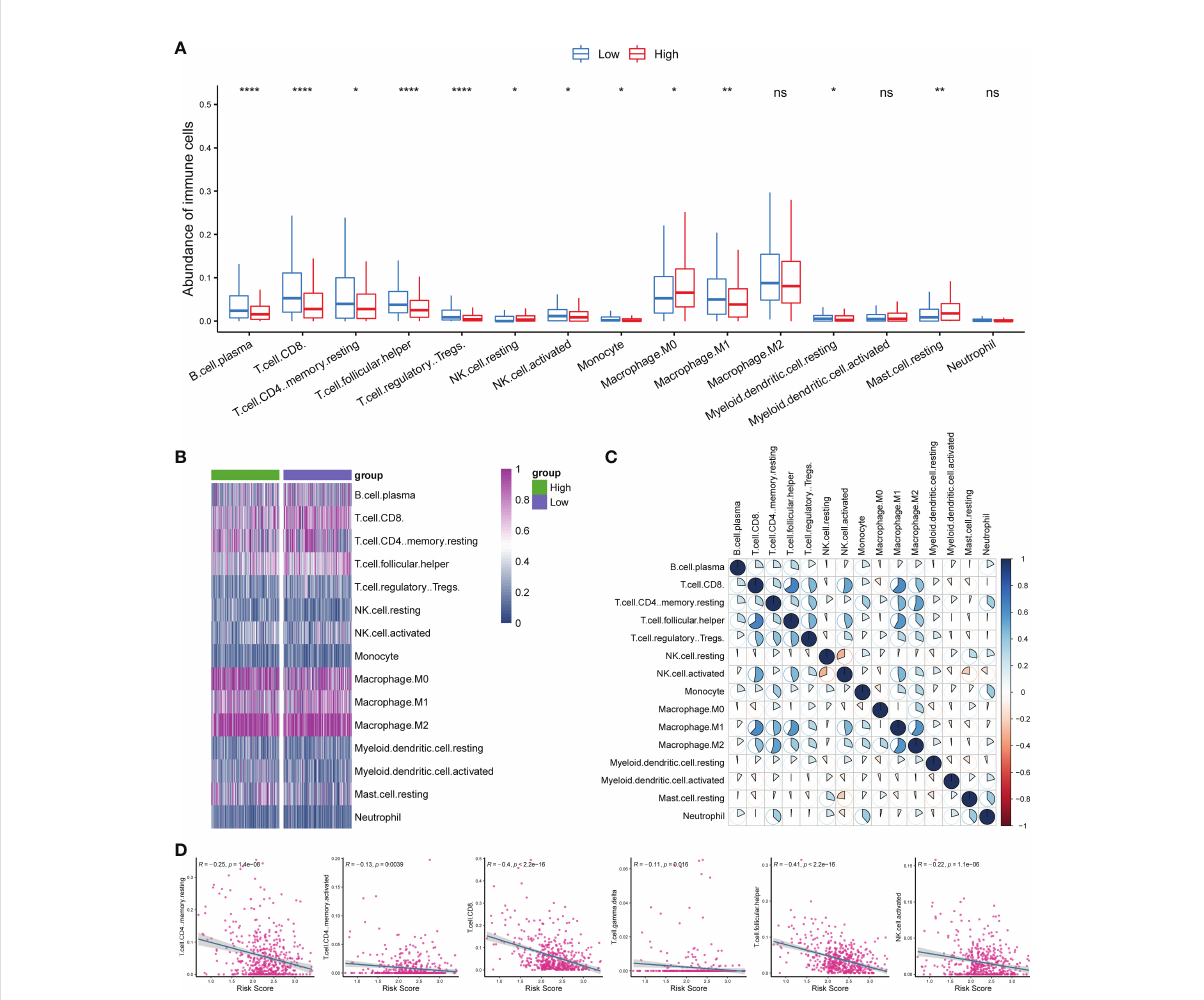
FIGURE 6 Investigation of the correlation of the immune microenvironment with circadian rhythm. (A) Comparison of the abundance of immune cells between the high- and low-risk groups. (B) The heat map analysis indicated a distinct expression of tumor-in fi ltrating immune cells between groups. (C) Activated NK cells were signi fi cantly positively correlated with CD8+ T cells, T cell follicular helper cells, and M1 macrophages. (D) The risk score was negatively correlated with CD4 + T cells, CD8 + T cells, gamma delta T cells, and activated NK cells. * P < 0.05, ** P < 0.01, and *** P <